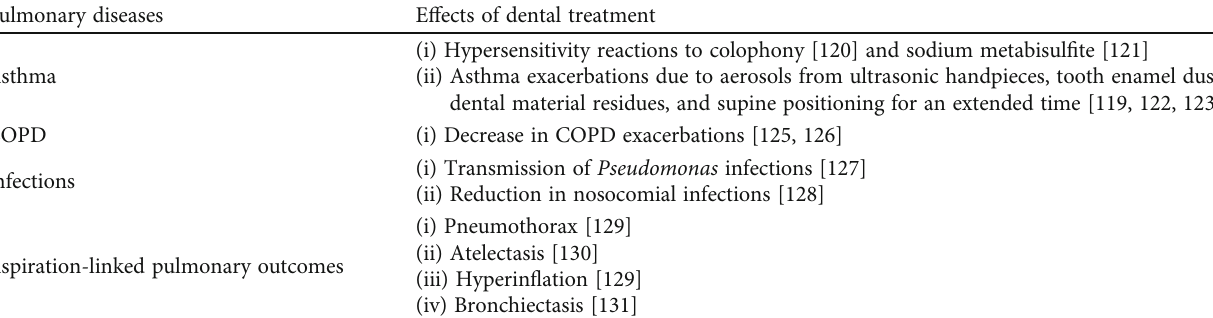
Table 1: Summary of dental treatment and pulmonary